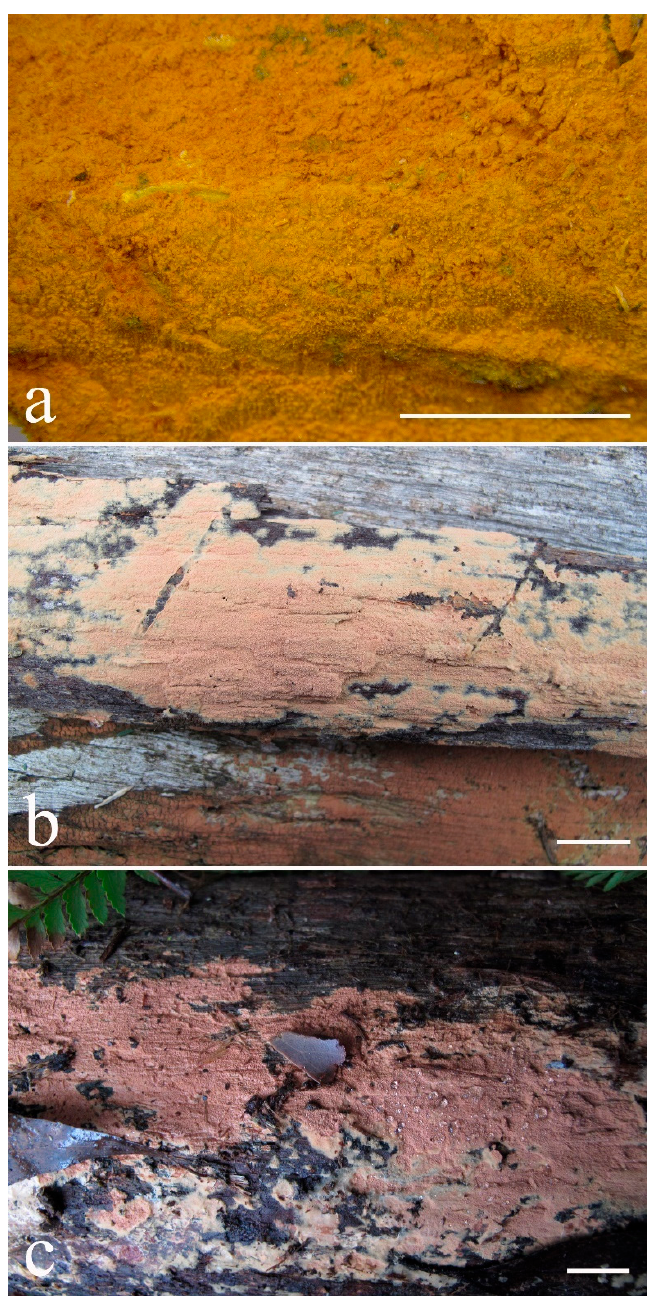
Figure 22. Basidiocarps of Xylodon australis . ( a ) LWZ 20180513-6 (epitype); ( b ) LWZ 20180509-15; ( c ) LWZ 20180512-14.— Scale bars: a = 5 mm; b , c = 1 cm.